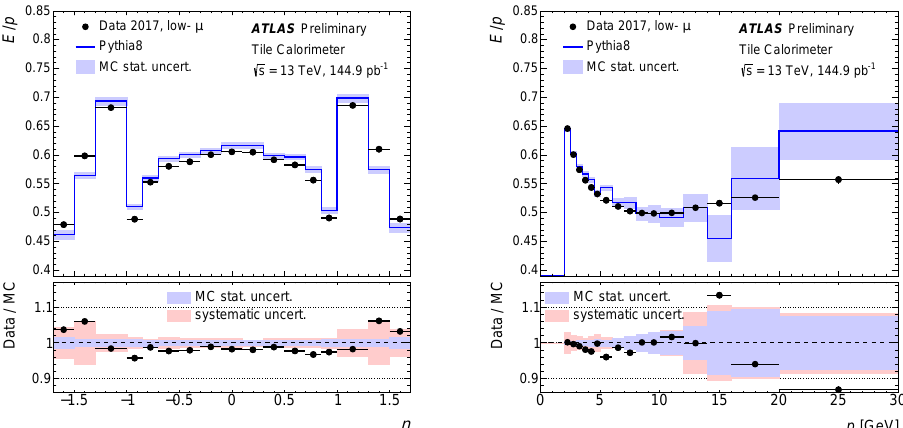
Figure 7. The TileCal response to isolated charged hadrons characterized by the energy over mo- mentum ratio E / p , as a function of pseudorapidity ( left ) and momentum ( right ). The lower panels show the ratio of data to MC simulation, systematic uncertainties cover the effects of residual con- tamination from neutral particles and energy mis-measurements due to energy losses in front of the calorimeter [7].